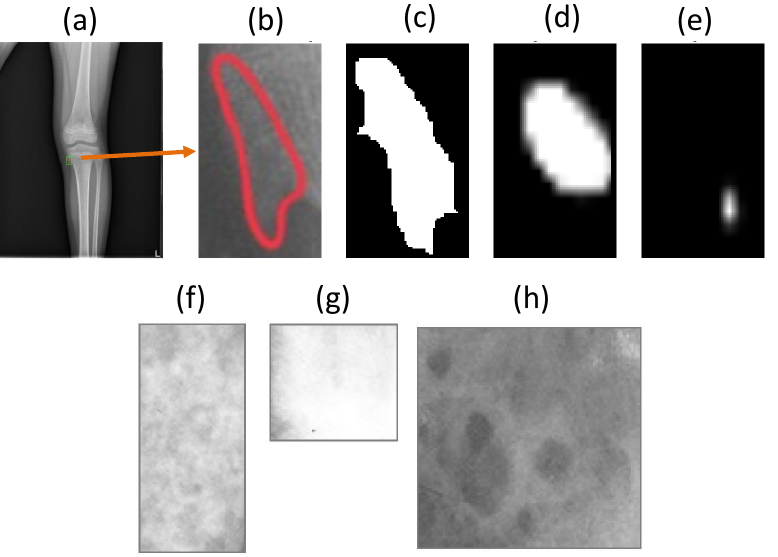
Figure 1. (Row 1) The robust multi-level features used to help detect the very small tumor region. From left to right, ( a ) original image containing the very small tumor region, ( b ) zoomed-in view of the tumor region, ( c ) the ground-truth, ( d ) the result with multi-level distance features, and ( e ) the result without those features. (Row 2) Meaningful bone tumor matrices of knee bone tumor classifi- cation shown in ( f – h ). It is proven to be a highly predictive feature of bone tumor classification in [5]. This explains why global and patch-based approaches should be applied to distinguish between benign-tumor and malignant-tumor